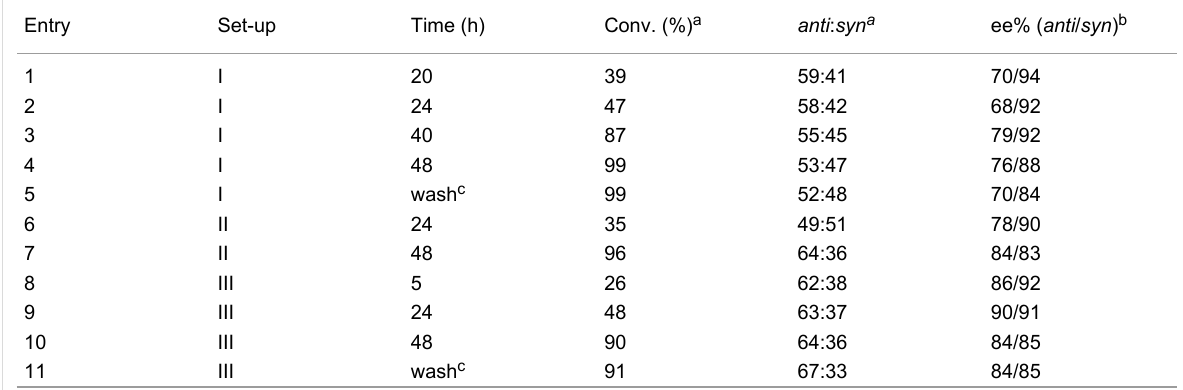
Table 3: Three different set-ups for the aldol reaction in continuo .